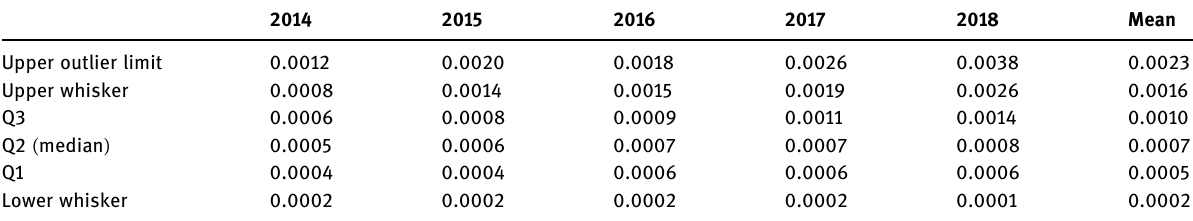
Table 2: Quartiles calculated per year on the SD values [ m ] of the ZTD estimated from the routine processing of